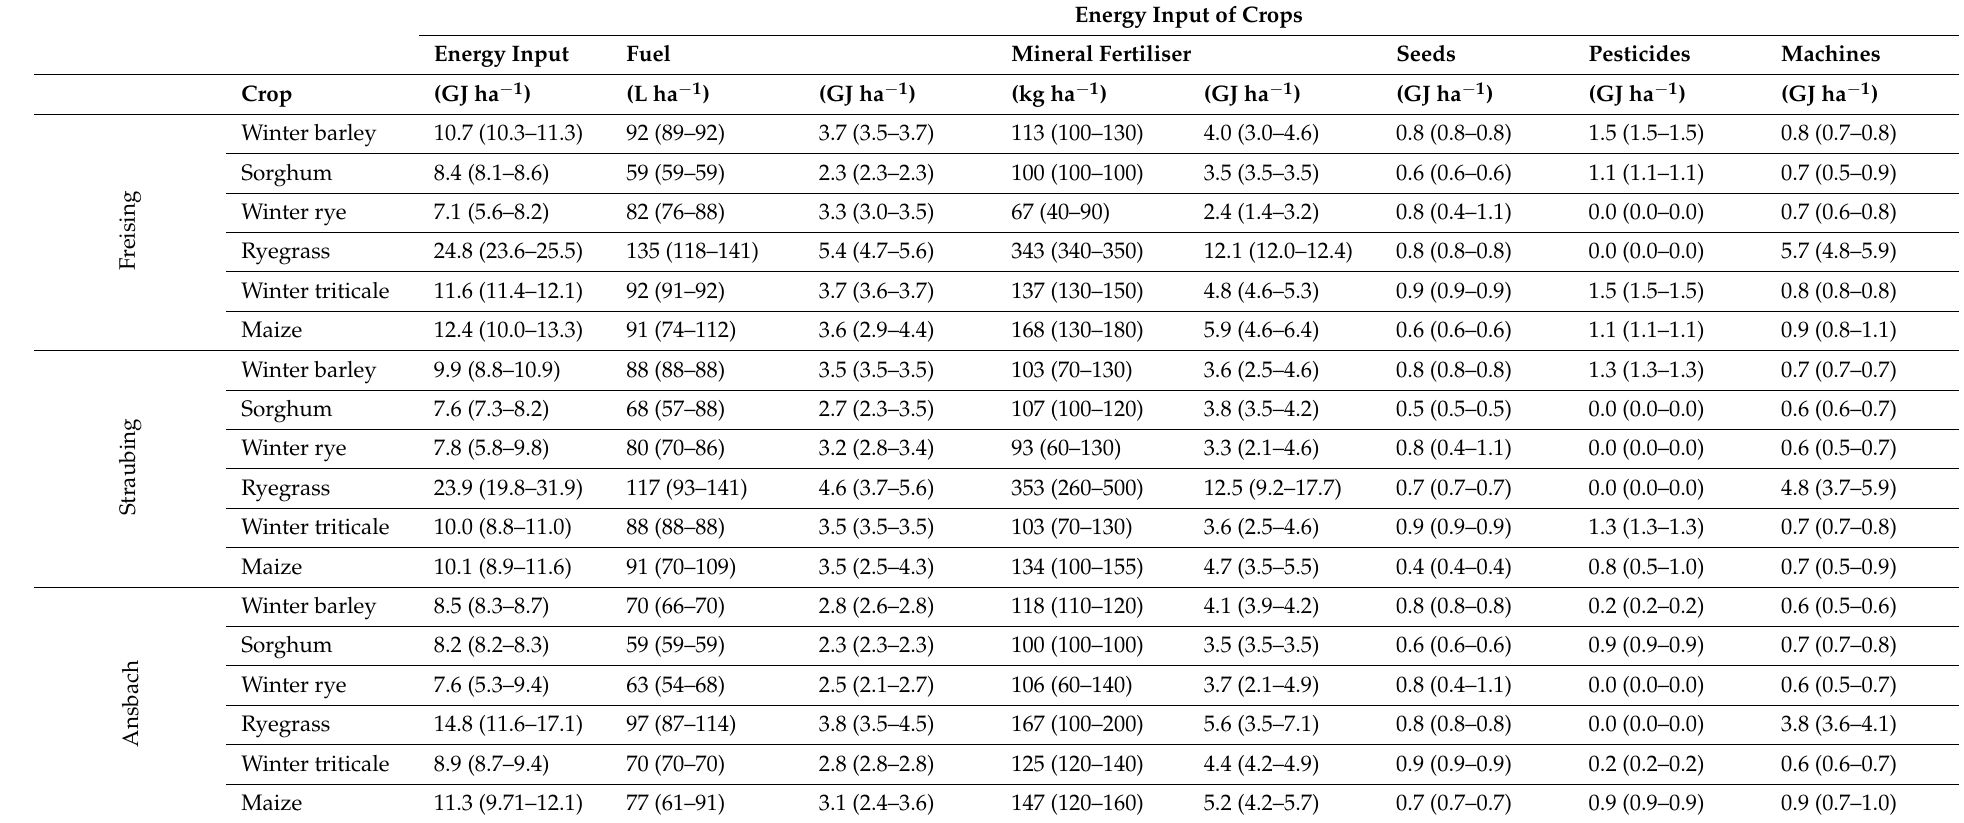
Table 4. Mean energy input at the experimental sites. Minimum and maximum values across trial years in